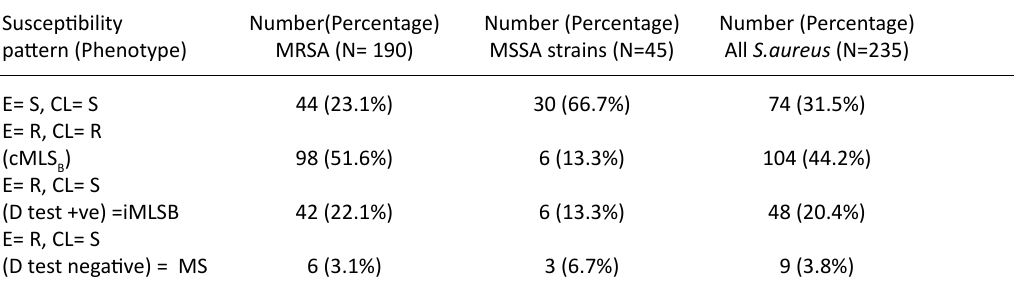
Table 3. Susceptibility pattern ofclindamycin and erythromycin among the isolates